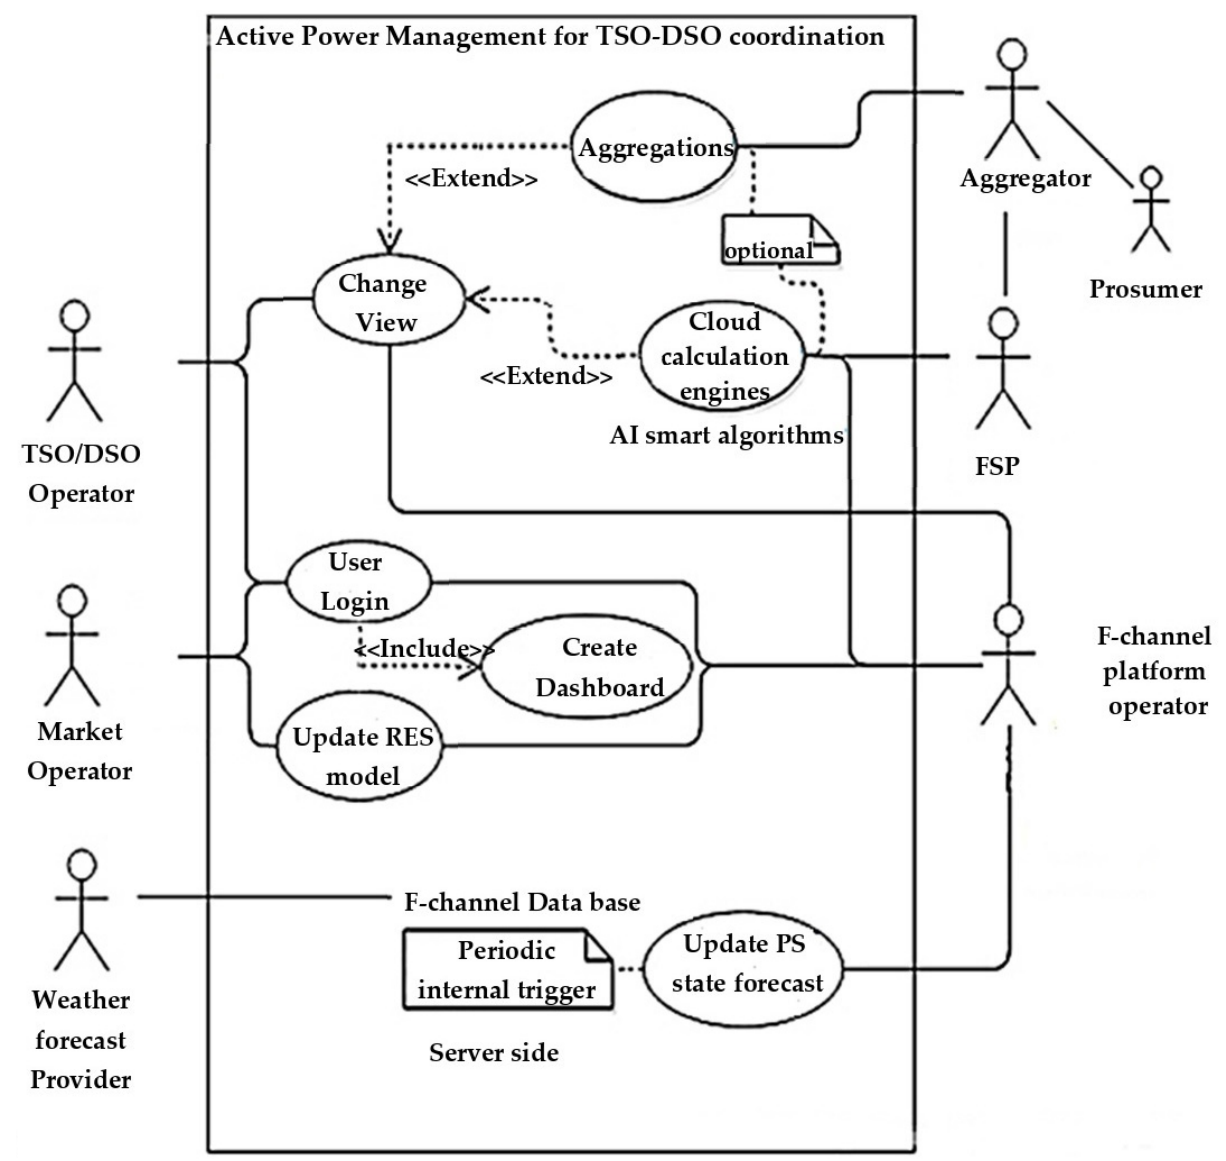
Figure 7. Diagram of the business use case.